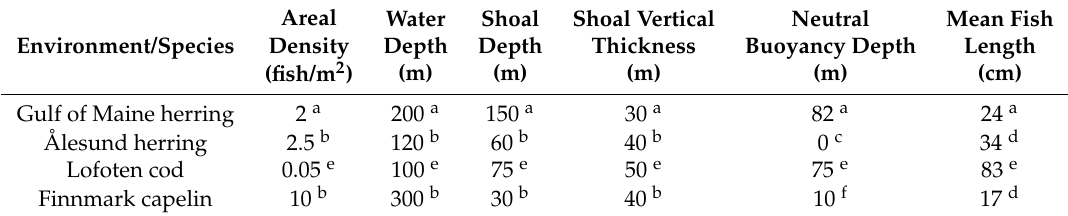
Table 1. Environmental parameters used for attenuation calculations in Figure